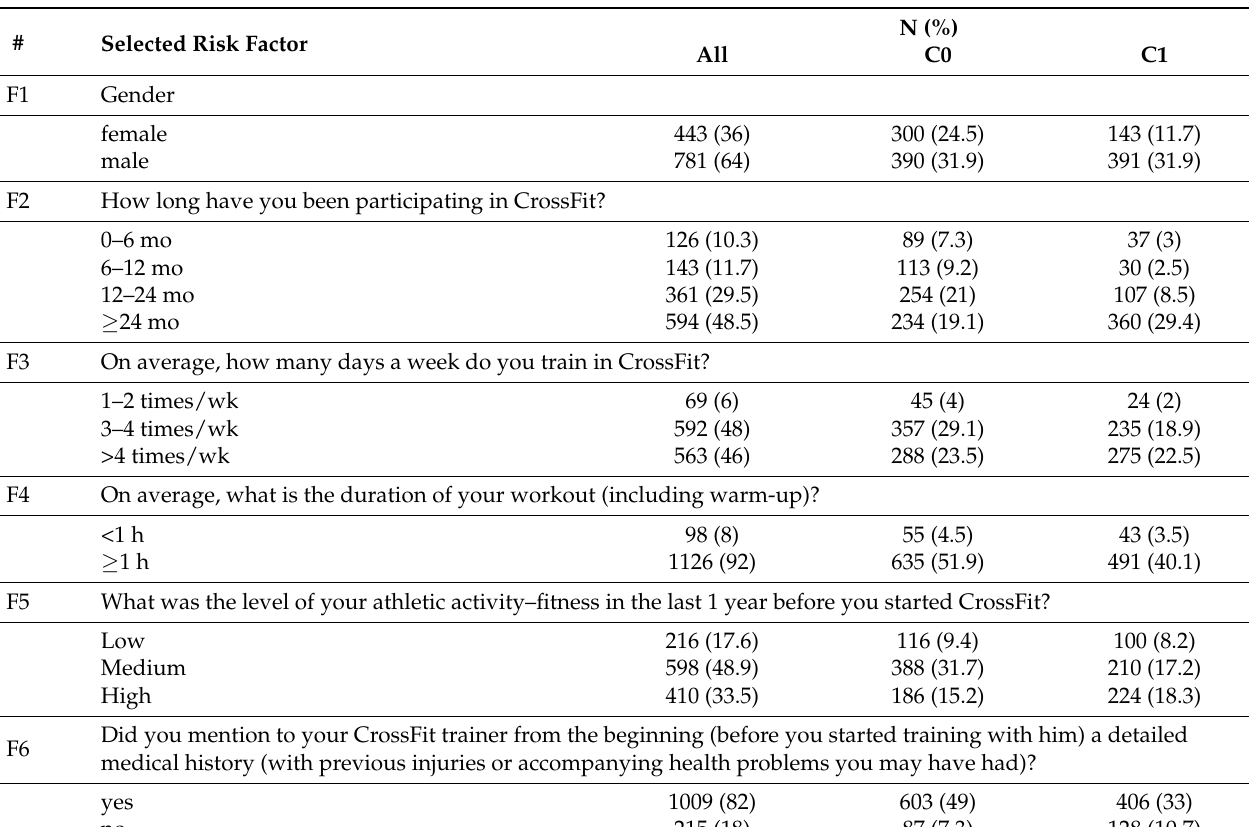
Table 4. Number of samples (and percentages) in the entire population as well as in the two classes considered in our study (C0: healthy participants and C1: injured